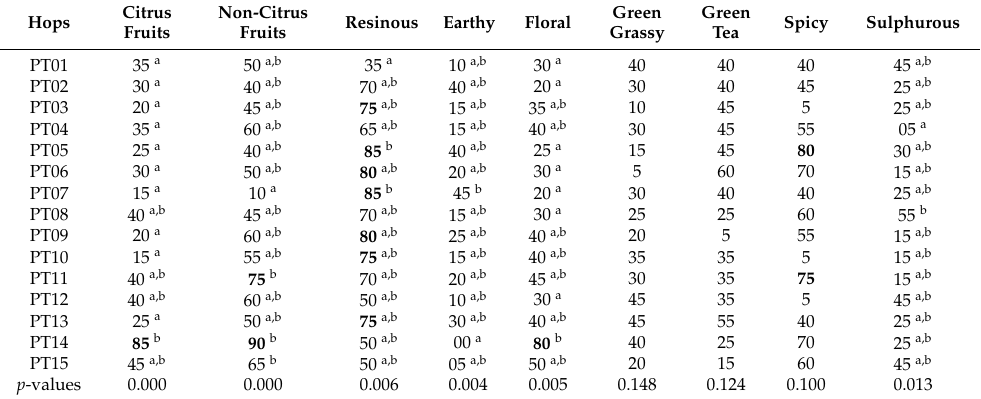
Table 2. Sensory analysis of Portuguese hops performed by Check-All-That-Apply (CATA)